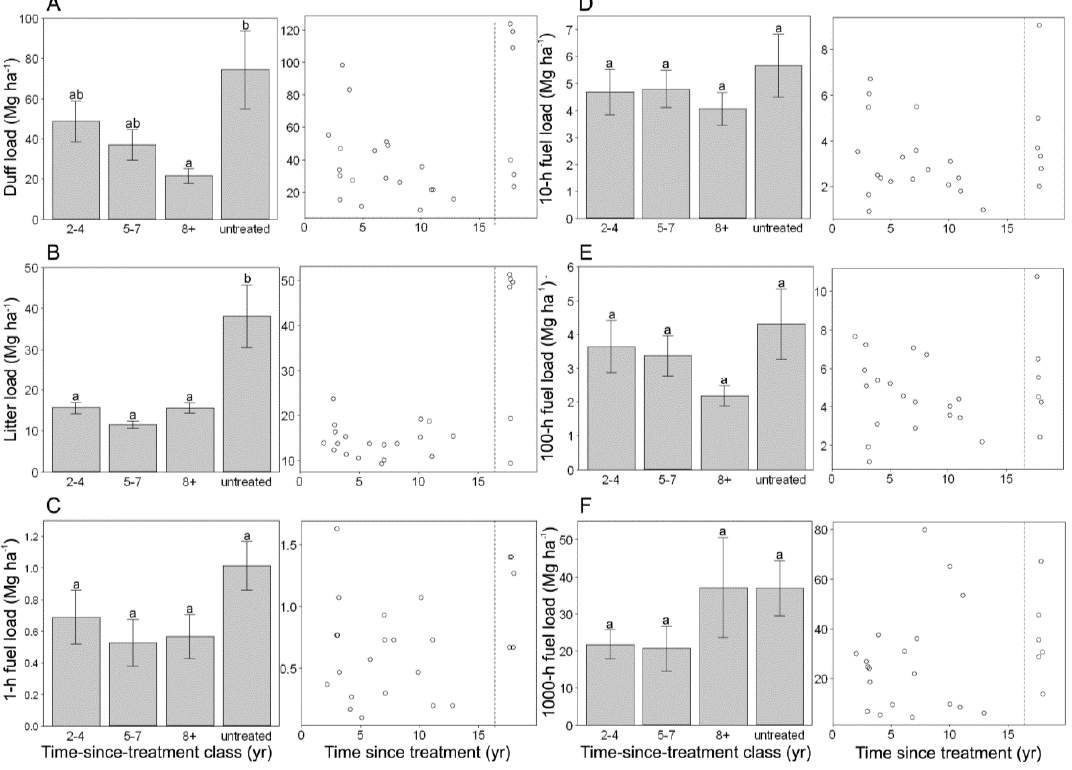
Figure 3. Dead surface fuel load by category in the mixed conifer chronosequence ( n = 19) and control ( n = 6) sites. Fuel load in the ( A ) duff layer; ( B ) litter layer; and the ( C ) 1-h; ( D ) 10-h; ( E ) 100-h; and ( F ) 1000-h timelag categories. Left-hand panels show means ± SE for the three age class groups and the control group. Different letters above each bar indicate significant difference in means between groups (Tukey’s HSD multiple comparison test, p < 0.05). Right-hand panels show the relationship between time since treatment and each fuel category. Vertical dashed lines separate treated and untreated study